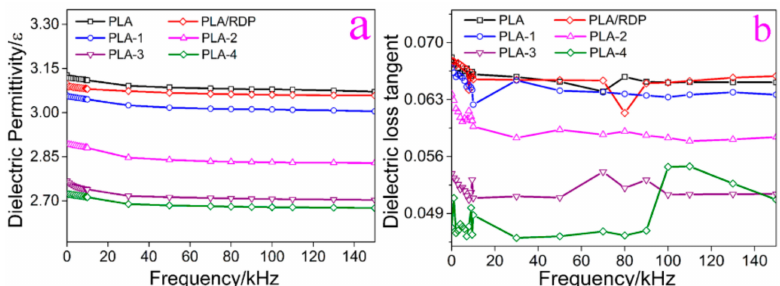
Figure 7. Dielectric permittivity ( a ) and dielectric loss tangent ( b ) of the films.